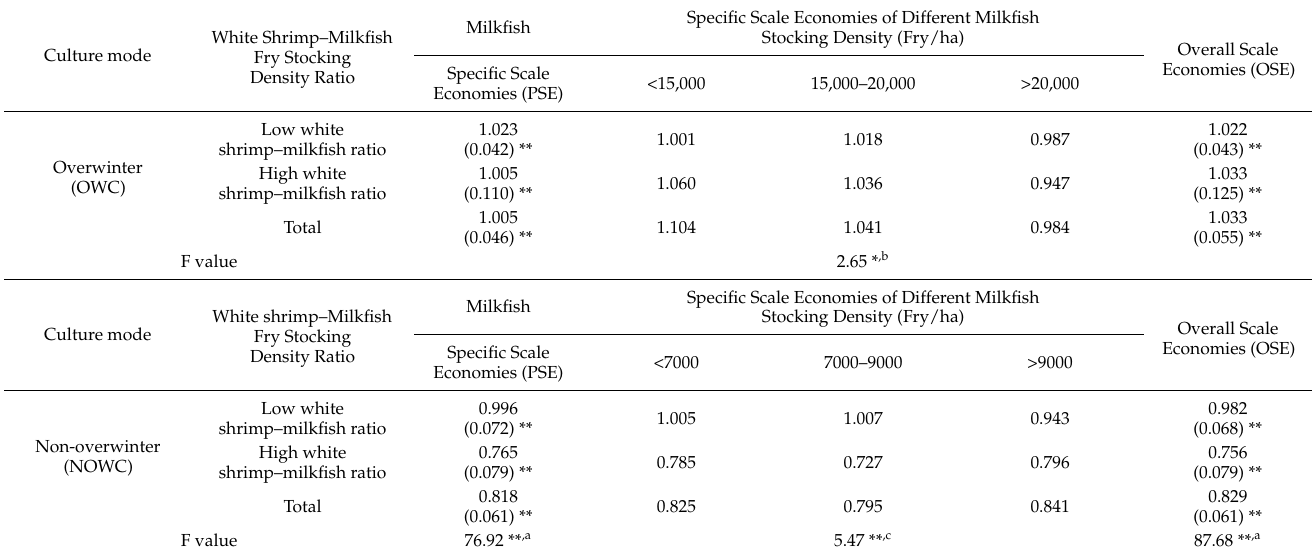
Table 5. Specific scale economies and overall scale economies of the observed milkfish farming household clusters.